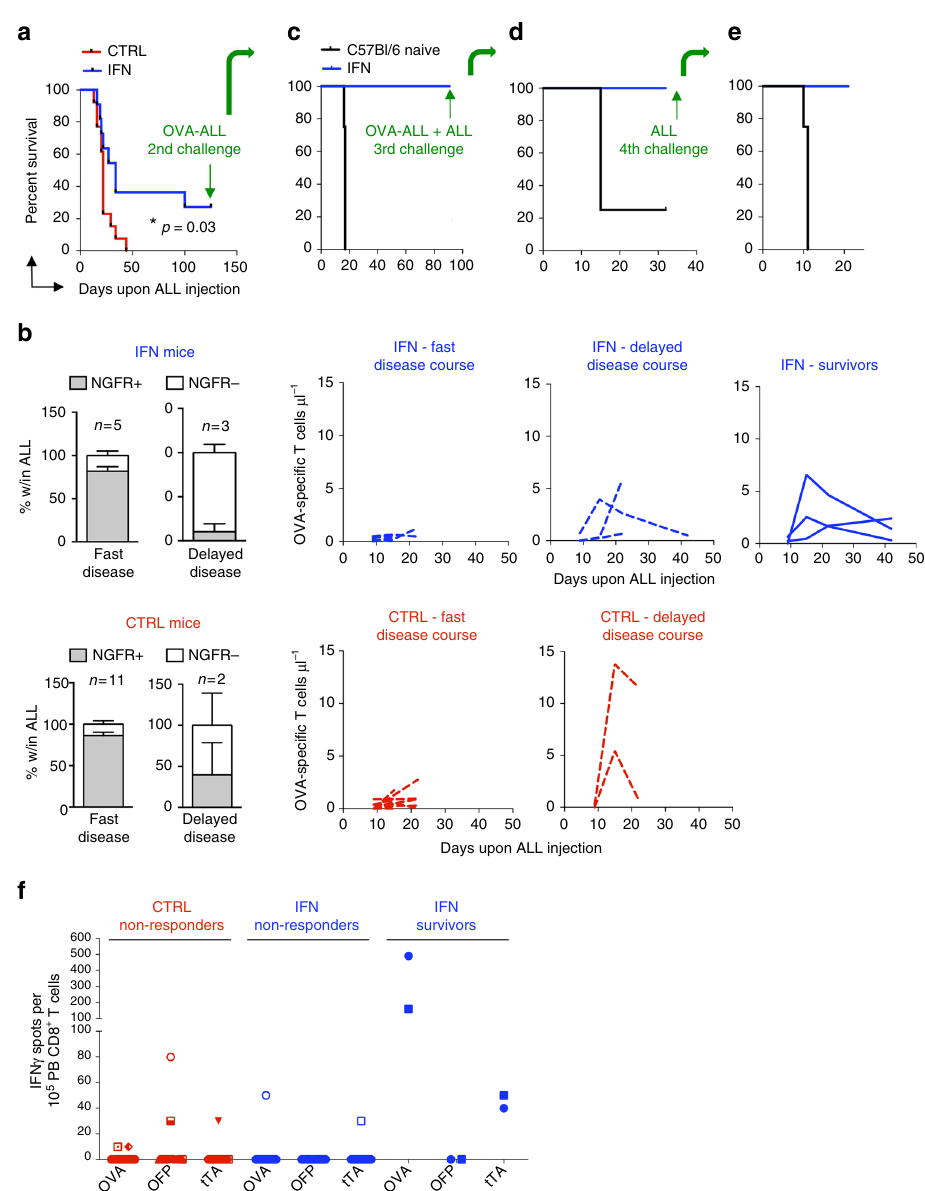
Fig. 6 IFN gene therapy promotes immune reactivity towards multiple surrogate TSAs and survival in a fraction of mice. a Survival curve of OVA-ALL- injected IFN ( n = 11) and CTRL ( n = 13) mice after the fi rst tumor challenge with OVA-ALL cells. * p < 0.05, Mantel – Haenszel test. b NGFR expression on BM-in fi ltrating ALL (or PB ALL for those mice for which BM analysis is not available) and absolute numbers (mean ± SEM) of OVA-speci fi c T cells (each line represents a mouse) in the PB of IFN ( n = 8) and CTRL ( n = 13) mice showing fast or delayed disease course (fast disease course: CTRL: 13 – 29 days (range), 20.4 ± 1.3 (mean ± SEM), n = 11; IFN:16 – 27 days, 20.8± 1.8, n = 5; delayed disease course: CTRL: 34 – 44 days, 39 ± 5, n = 2; IFN: 34 – 100 days, 56 ± 22, n = 3) and of long term surviving IFN ( n = 3) mice. c , d , e Survival curves of long-term surviving IFN mice from ( a ) subjected to subsequent tumor challenges with the indicated ALL cells ( c : n = 3 long-term surviving IFN mice from a vs. 4 naive mice; d : same 3 surviving mice from a , c vs. 4 naive mice; e : 2 of the 3 surviving mice from a , c , d vs 4 naive mice. f PBMC from OVA-ALL injected IFN (non-responders, n = 14; long-term survivors, n = 2) and CTRL (non-responders, n = 16) mice tested by IFN γ -ELISPOT (13 days upon tumor injection) against the EL4 target cell line transduced with the NGFR-OVA bidirectional LV or PGK-OFP or PGK-tTA LV. Each dot represents a mouse tested against all three surrogate tumor-speci fi c